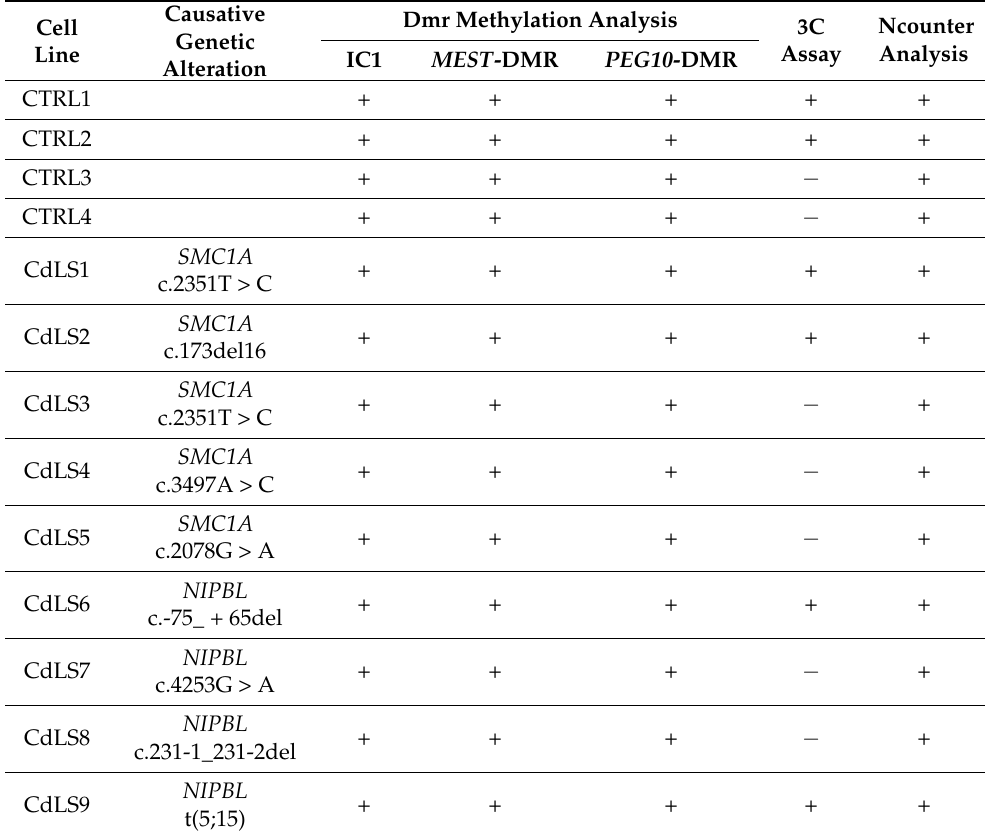
Table 1. Schematic overview of the experimental